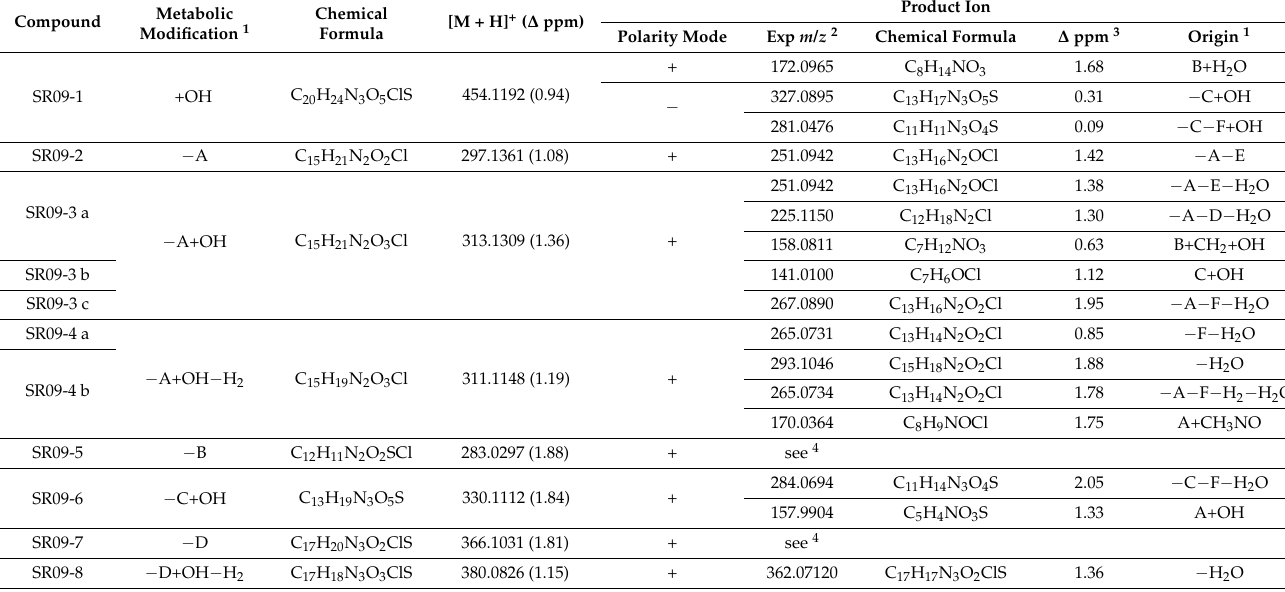
Table 2. Characterization of metabolites detected in HLM incubation samples with SR9009 by LC–HRMS analysis.